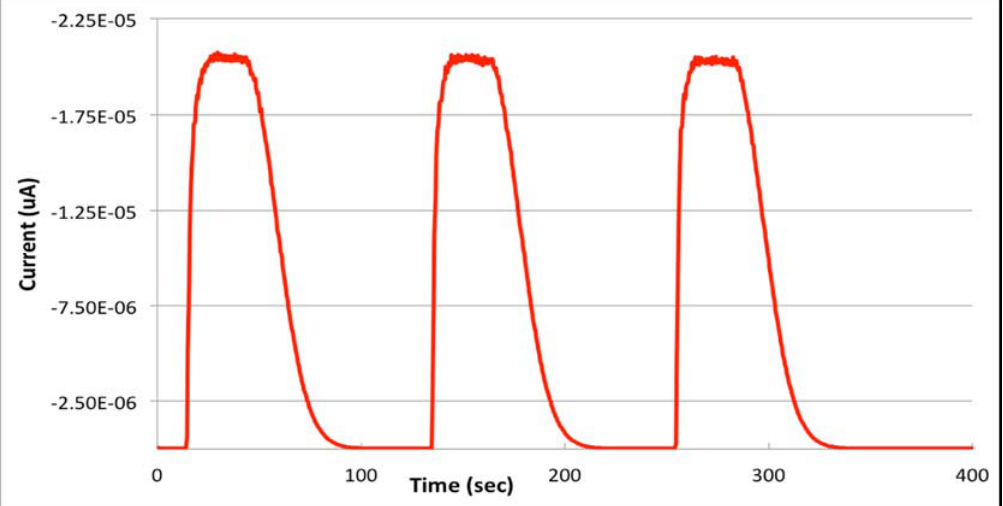
Figure 7. Shape and reproducibility of consecutive flow injection analyses in potassium ferricyanide reduction at 0 mV as model reaction.